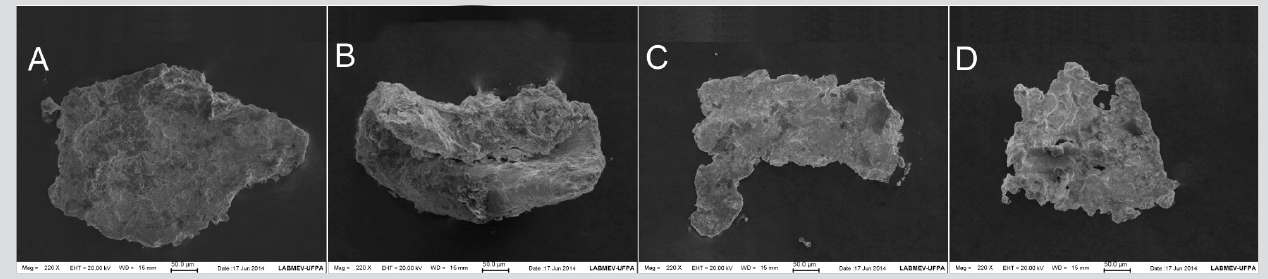
Figure 13 - Backscattered electron images of individual gold particles hosted in fractures of metasandstone. All particles are flattened, with irregular edges and rugose surface.